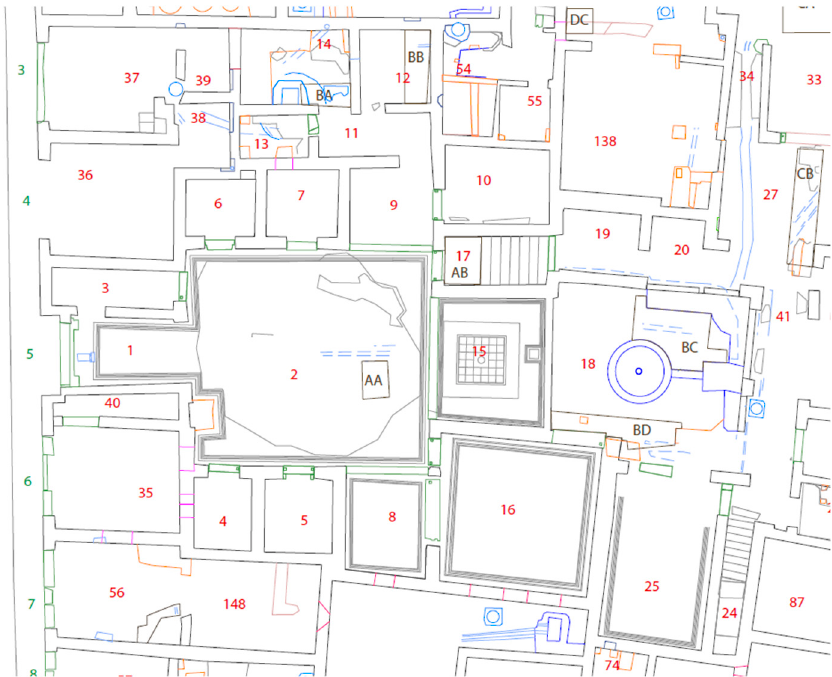
Figure 6. Floor plan showing the House of Marcus Lucretius. Illustration Courtesy: the Expeditio Pompeiana Universitatis Helsingiensis (used by permission).